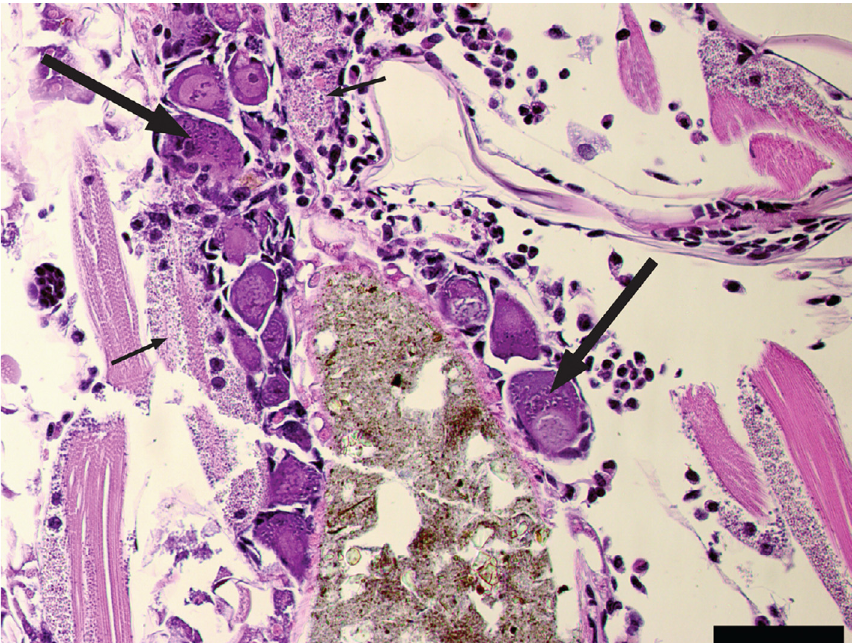
Figure 3. Histological sections (hematoxylin and eosin) of a Diporeia sp. sample collected from Lake Superior. Notice the microsporidians ( Dictyocoela diporeiae n. sp.) filling and replacing muscle tissues (small arrows) surrounding the ovaries (large arrows). Scale bar = 100 l (60–100 nm) were stained with 2% (w/v) uranyl acetate in 50% ethanol followed by Reynold’s lead citrate and examined in a JEM-100 CX II electron microscope at an accelerating voltage of 100 kV. site near SU-01M (SU-23B) was extracted using the DNeasy